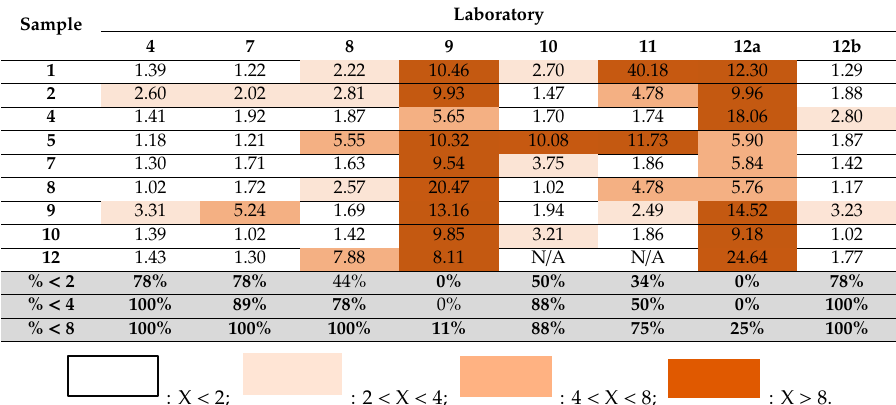
: X < 2; Table 3. Fold-change of laboratory geometric mean potency estimates from the overall median potency estimate for each sample.